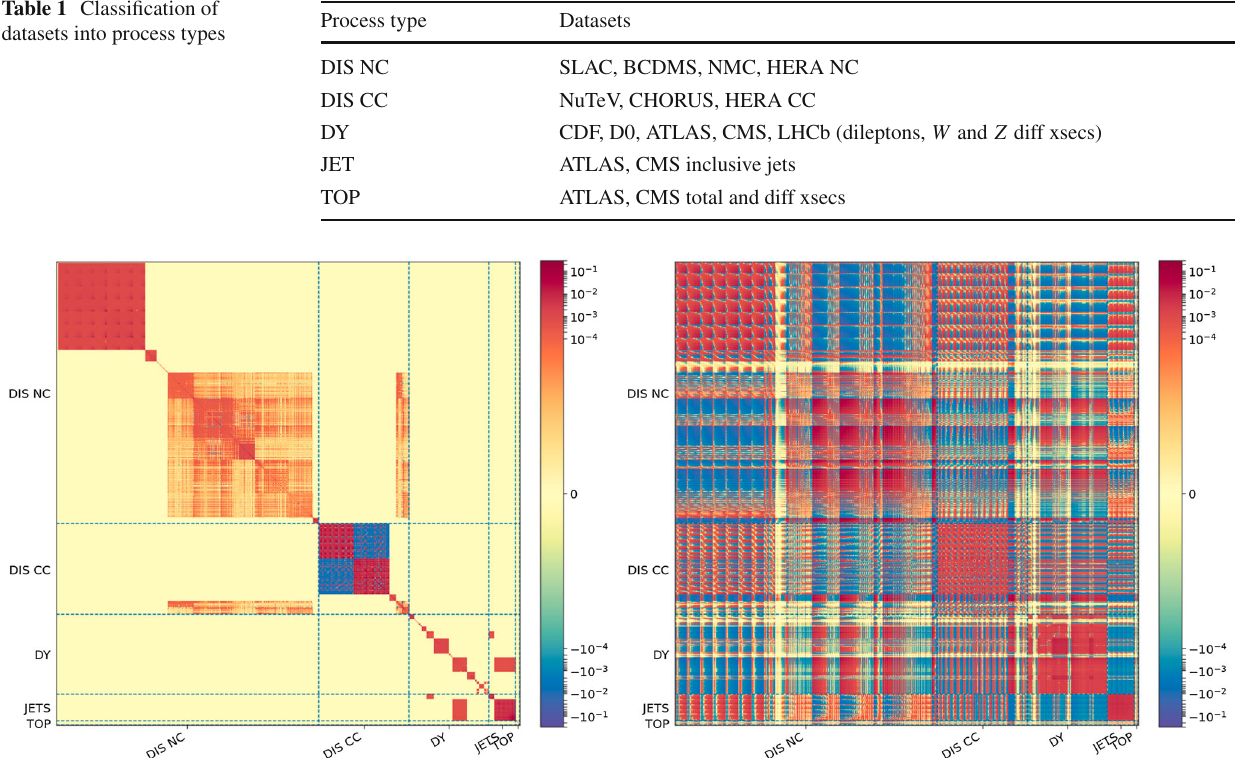
Fig. 1 The experimental covariance matrix, C ij , normalized to ( 0 ) the theoretical predictions T (left), and the corresponding the- i ory covariance matrix for MHOU, S ij (right). The datasets are